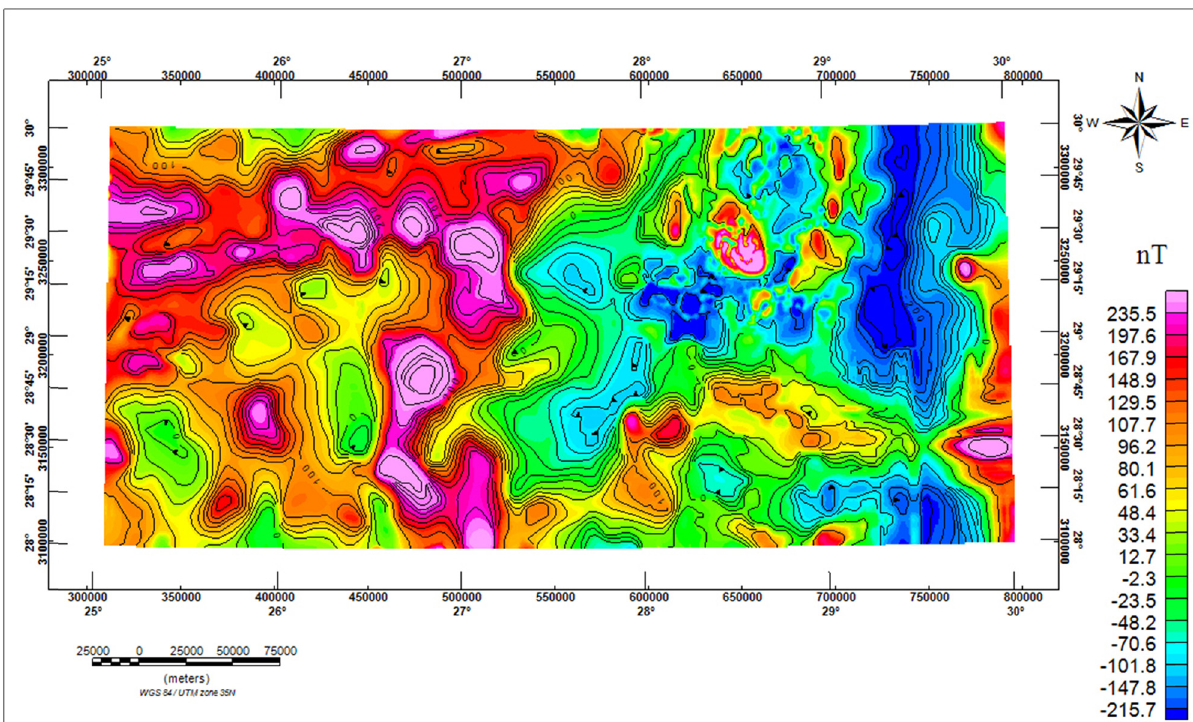
Figure 10: RTP magnetic